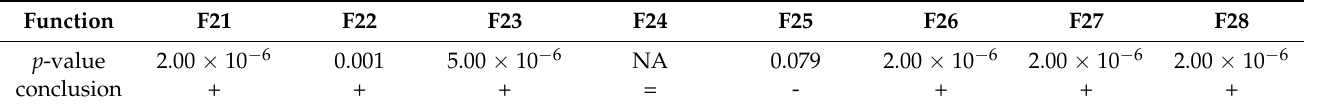
Table 12. Statistical results of Wilcoxon signed-rank test on fixed-dimension multimodal